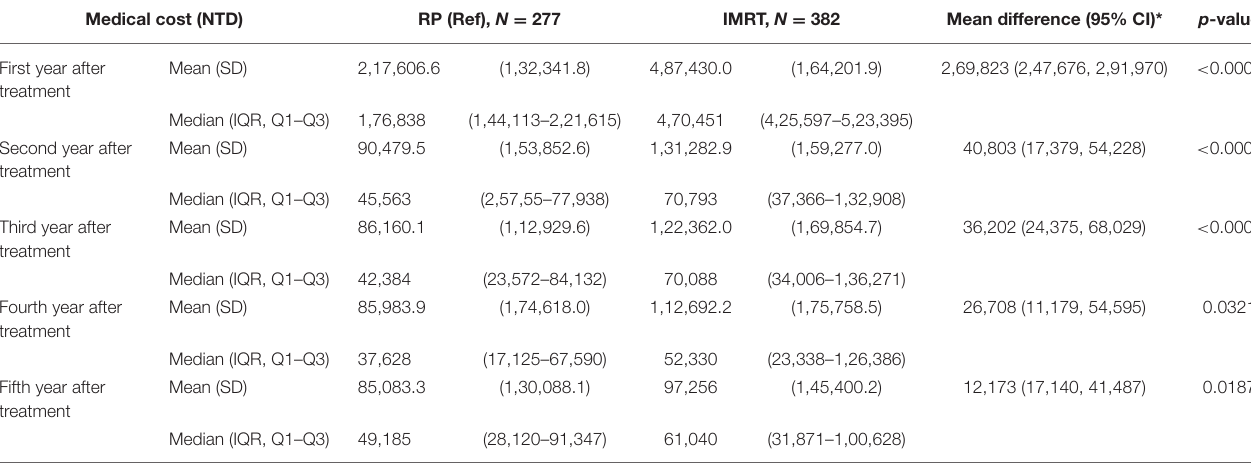
TABLE 3 | Generalized linear mixed model of medical reimbursement for urinary diseases or treatment-related complications stratified by RP and IMRT. Medical cost